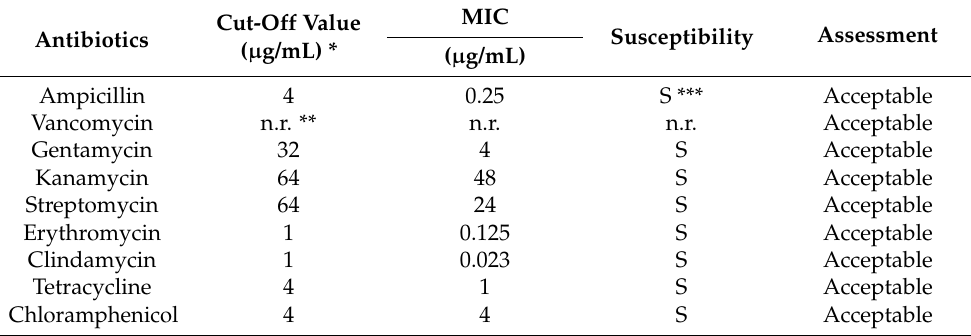
Table 4. Antibiotics susceptibility of L. paracasei EPS